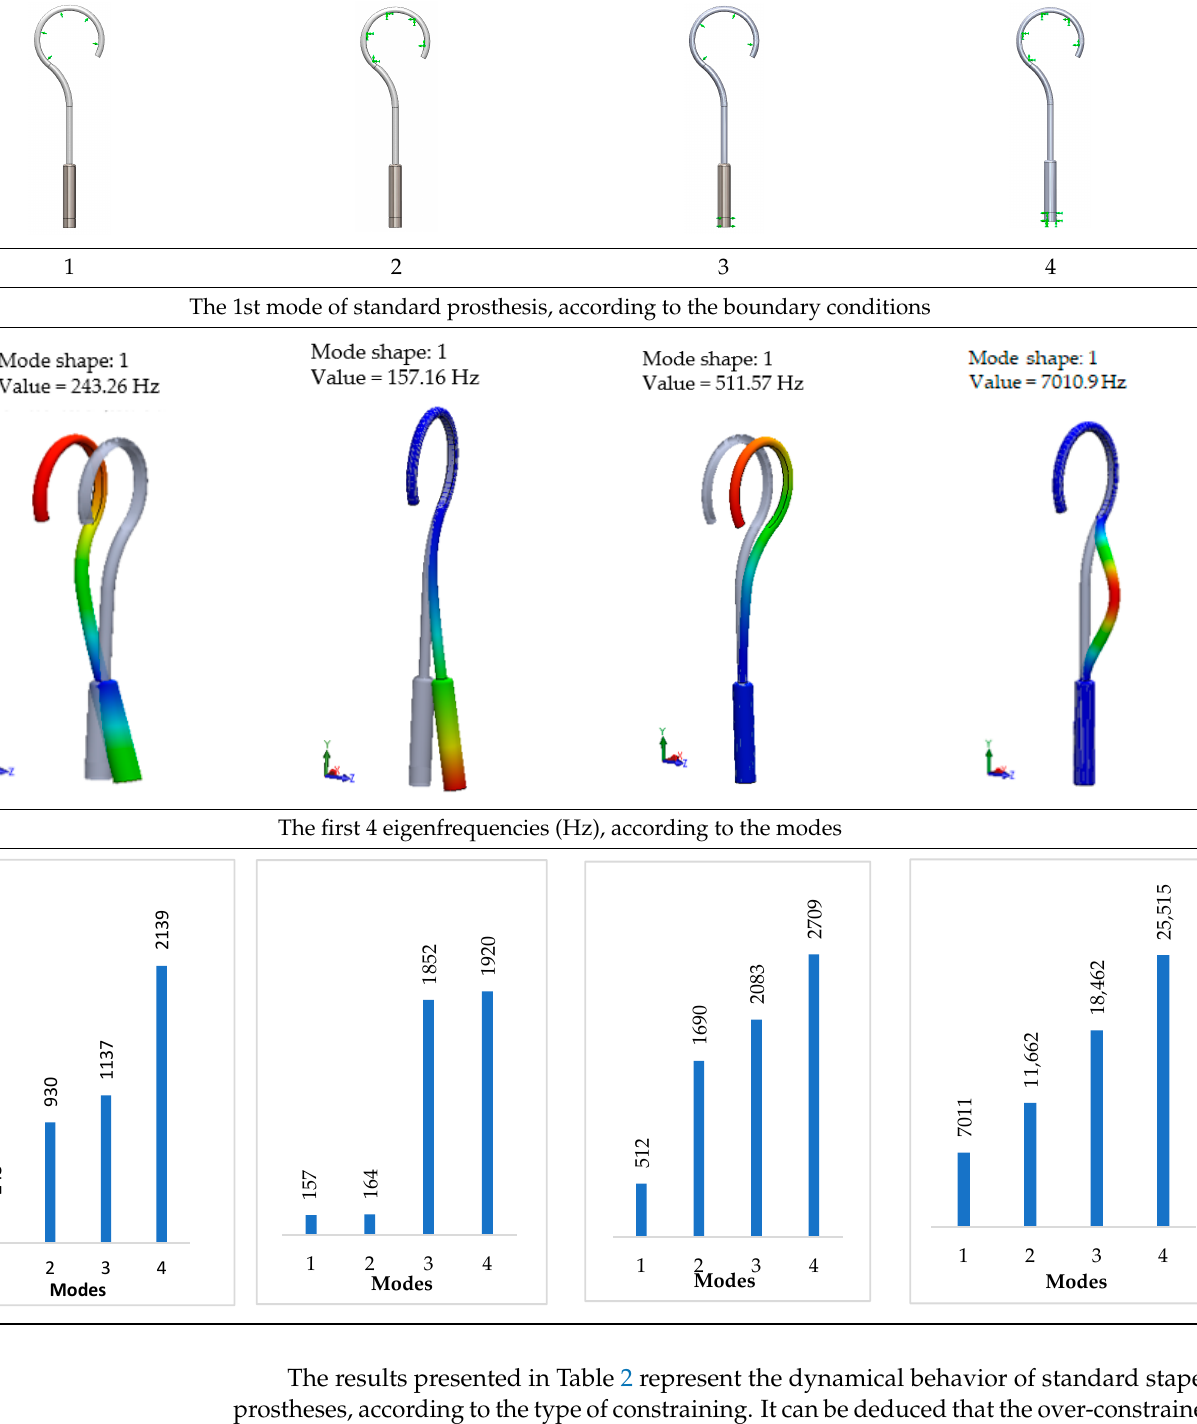
Table 3. The results of eigenfrequency analysis of modified standard prosthesis: the 1st mode and the eigenfrequencies (Hz) of first 4 modes.